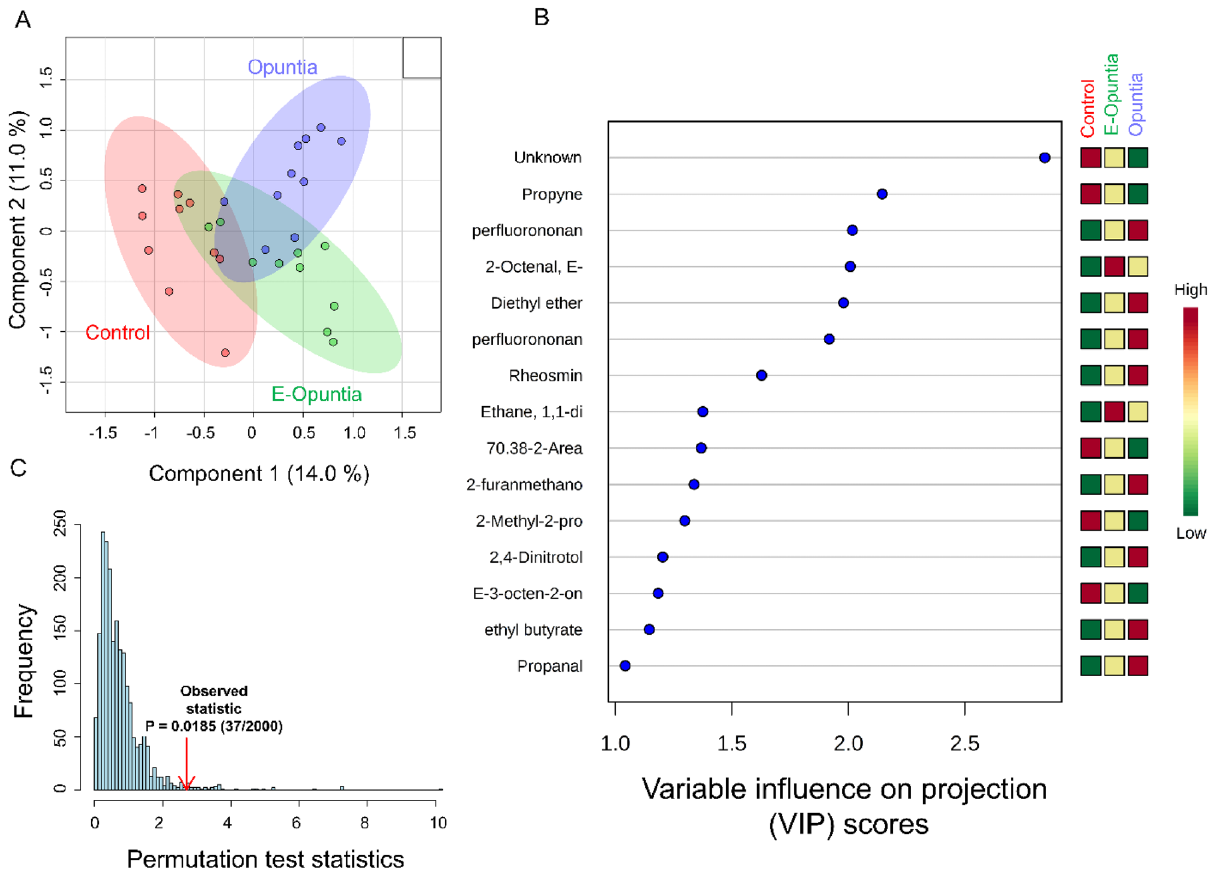
Figure 3. ( A ) Partial least squares-discriminant analysis (PLS-DA) showing 2 clusters for 3 treatments (Control, E-Opuntia, Opuntia); ( B ) the metabolites ranked by variable importance in projection (VIP) after the end of dietary treatment (Day 45). ( C ) PLS-DA model validation by permutation tests based on separation distance of treatments. The p-value based on permutation was P = 0.059 (119/2000). Metabolomics data